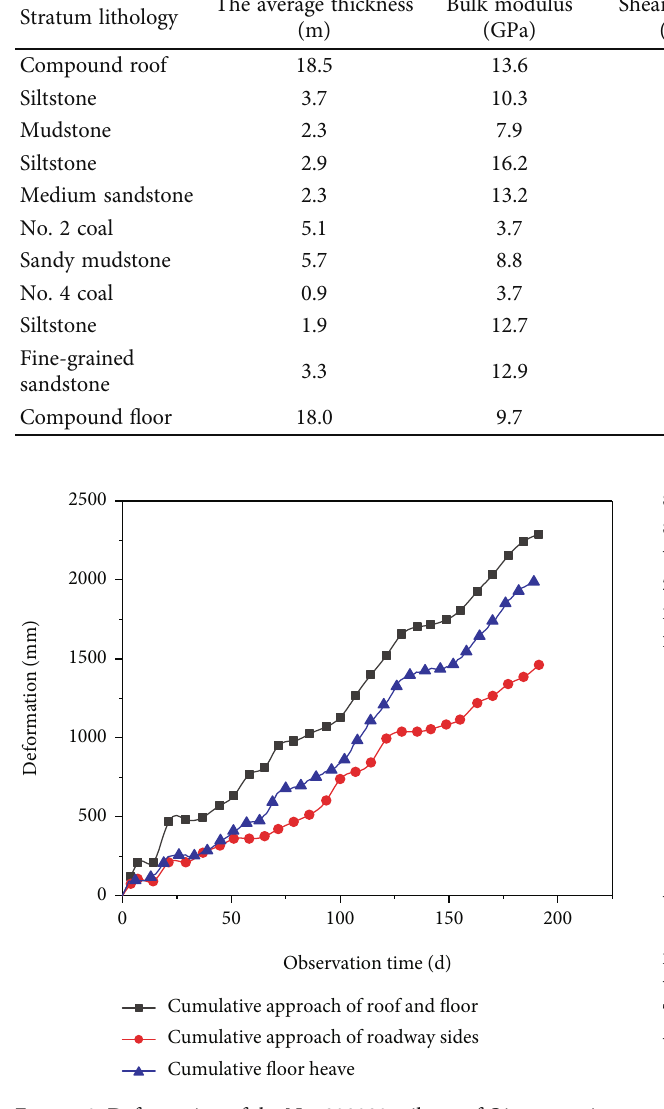
Figure 2: Deformation of the No. 020202 tailgate of Qingyun mine with the original